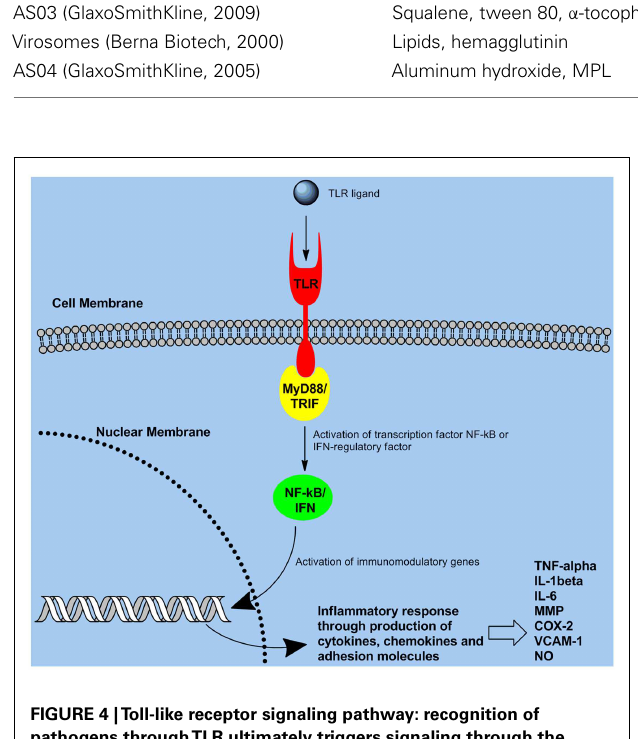
(TIR) domain (1). TLRs utilize activation of intracellular